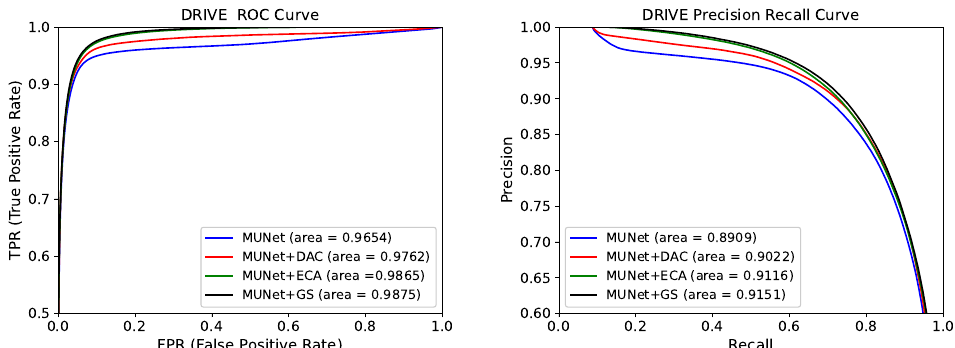
Figure 3. Receiver operating characteristic (ROC) curve and precision recall (PR) curve for five models on the DRIVE